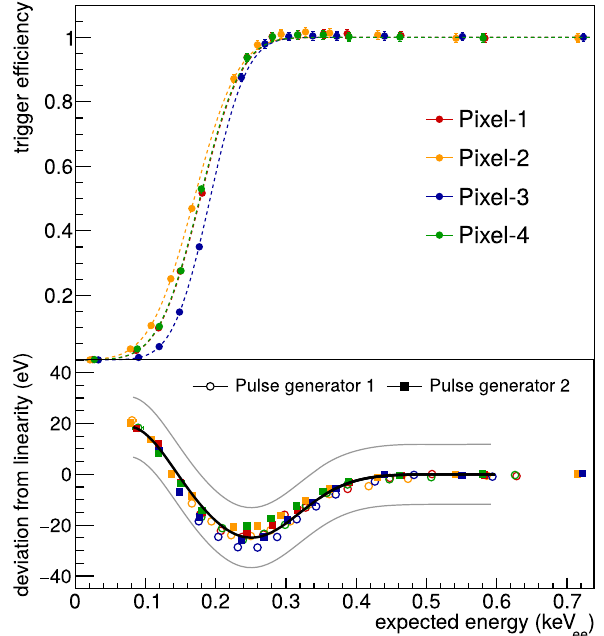
Fig. 5 Top: measured trigger efficiencies for the four pixels (points) and best-fit model (dashed lines) using the analytical description of Eq. (2). Bottom: deviations from a purely linear energy scale measured with two different pulse generators (points) described by the black line. The ± 12eV ee uncertainty band derived for the energy scale is shown in gray and it largely covers the small variations observed between the measurements and pixels. Both effects are included in the detector response matrix used to compute the expected energy distributions (cf.